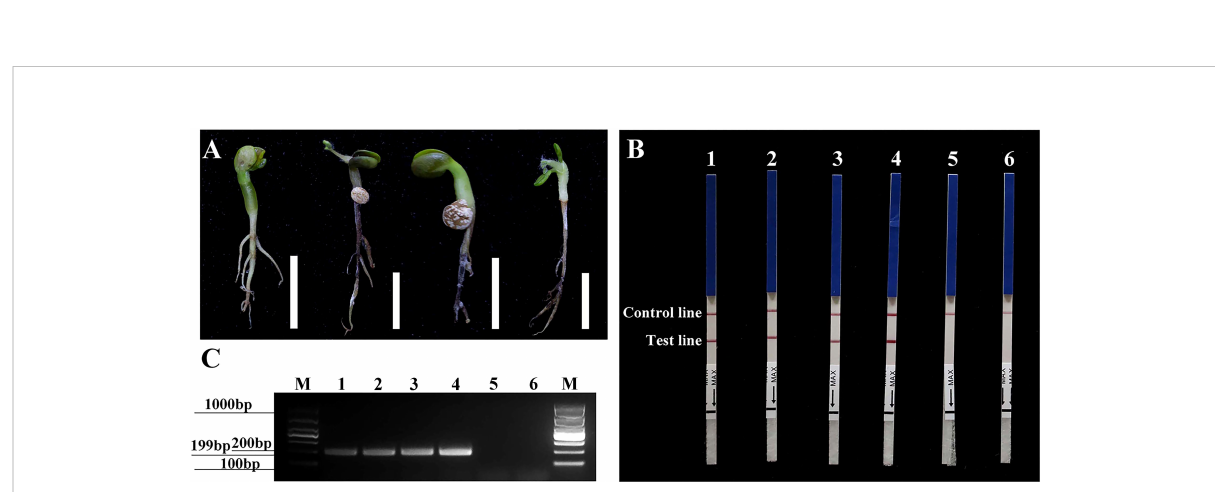
FIGURE 6 Detection of Phytophthora cinnamomi in the arti fi cially inoculated roots of sterile Lupinus polyphyllus Lindl. using Pcinn13739 RPA-LFD and conventional PCR assays. (A) 1 – 3, roots of arti fi cially inoculated sterile L. polyphyllus . 4, non-inoculated as a control. The white scale bar represents 1 cm. (B) Detection of arti fi cially inoculated samples by the RPA-LFD assay. 1 – 3, roots of arti fi cially inoculated sterile L. polyphyllus . 4, non-inoculated as a control. Genomic DNA (100 ng) of P. cinnamomi was used as a template in positive control (PTC), negative control (NTC). All dipsticks yielded visible control lines, indicating valid tests. (C) Detection of arti fi cially inoculated samples by conventional PCR assay. 1 – 3, roots of arti fi cially inoculated sterile L. polyphyllus . 4, non-inoculated as a control. M, Marker DL1000 (Takara Shuzo, Shiga, Japan). Genomic DNA (100 ng) of P. cinnamomi was used as a template in positive control (PTC), negative control (NTC). Each group of experiments was repeated in triplicate and yielded similar results.